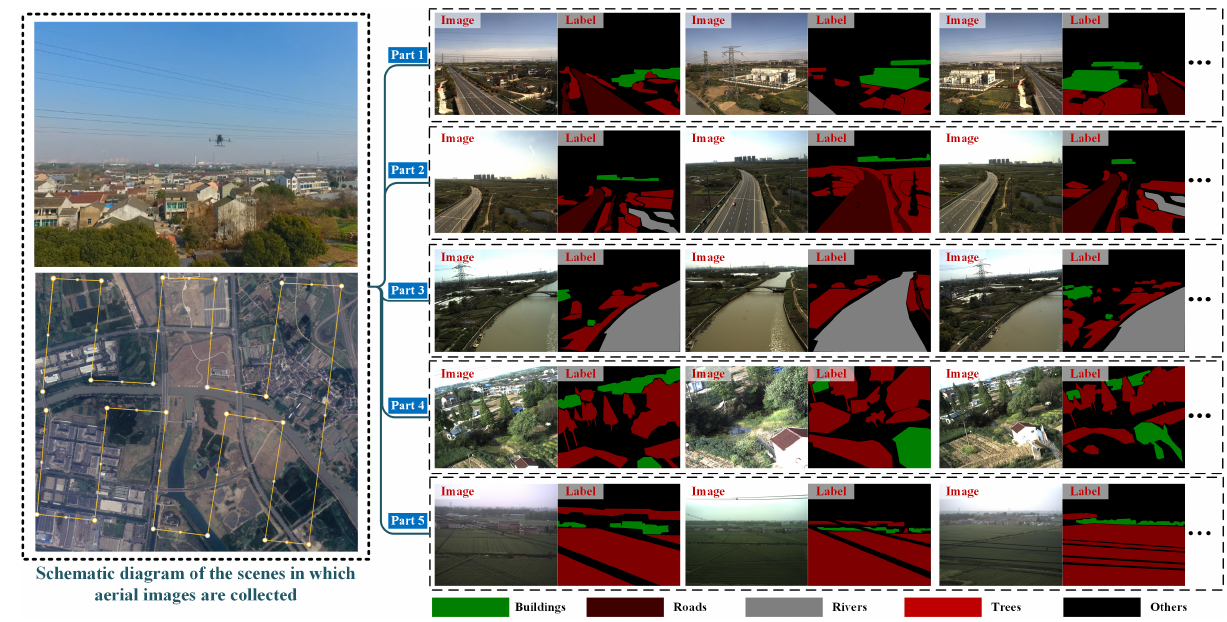
Figure 15. Samples of the aerial image classification dataset. Table 4. Details of the aerial image classification